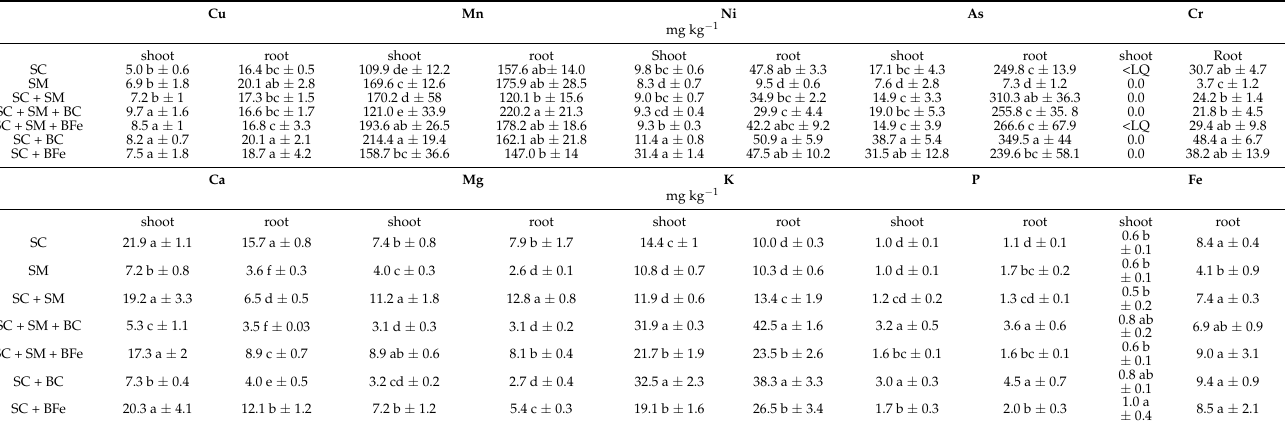
Table 6. Concentration of nutrients and PTEs in Ipomoea asarifolia